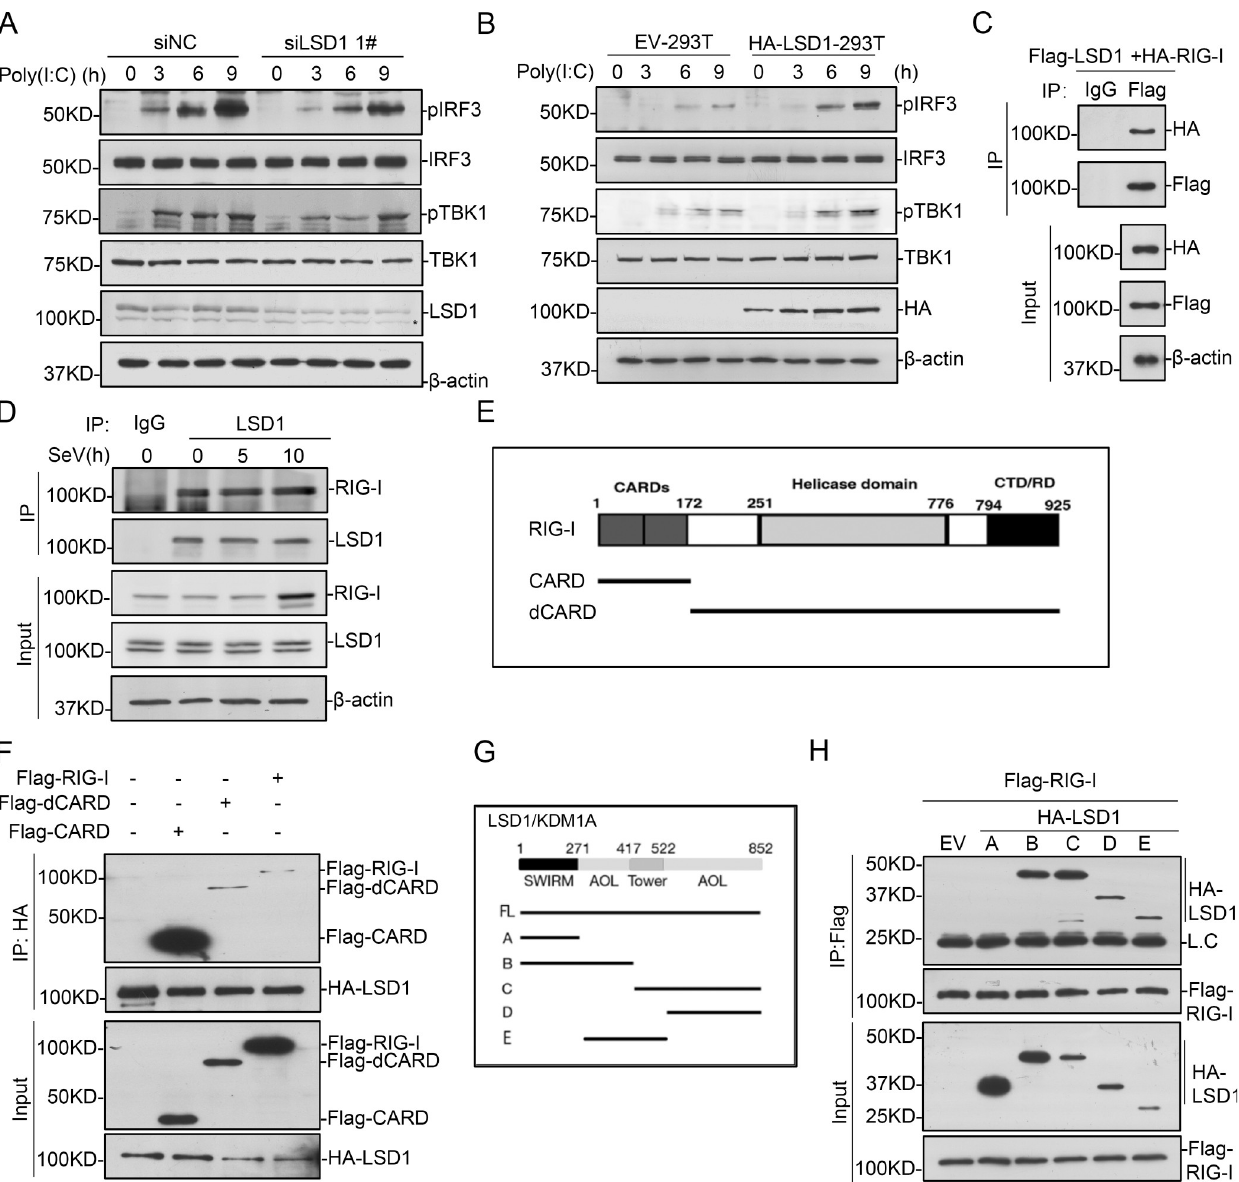
Fig 3. LSD1 is associated with RIG-I. (A) NC and LSD1 knock-down HEK293T cells were transfected with poly(I:C) for indicated hours. The phosphorylation levels of IRF3 and TBK1 were analyzed by western blotting. (B) LSD1-293T and control cells were transfected with poly(I:C) for indicated hours, and the phosphorylation levels of IRF3 and TBK1 were analyzed by western blotting. The relative amount of phosphorylated IRF3 and TBK1 was quantified with ImageJ software and labelled under the corresponding bands. (C) HEK293T cells were transfected with Flag-tagged LSD1 and HA-tagged RIG-I plasmid for 24 hr. Lysates were co-immunoprecipitated with anti-Flag body and immunoblotting analysis with indicated Abs. (D) HEK293T cells were infected with SeV for the indicated time and co-immunoprecipitated and immunoblotting were performed with indicated Abs. (E) Schematic of full- length RIG-I and its truncation. (F) HEK293T cells were transfected with Flag-tagged RIG-I full length or truncations and HA-tagged LSD1 for 24 hr, followed by co-immunoprecipitation and immunoblotting analysis with indicated Abs. ( G ) Schematic of full-length LSD1 and its truncated mutants. (H) HEK293T cells were transfected with HA-tagged LSD1 or its truncations and Flag-tagged RIG-I for 24 hr, followed by co-immunoprecipitation and immunoblotting analysis with indicated Abs. To map the residues of RIG-I whose polyubiquitination are regulated by LSD1, we first determined the domains regulated by LSD1. Two truncations of RIG-I, Flag-CARD or Flag- dCARD, were co-expressed with HA-LSD1 and Myc-Ub in cells, respectively. The result of